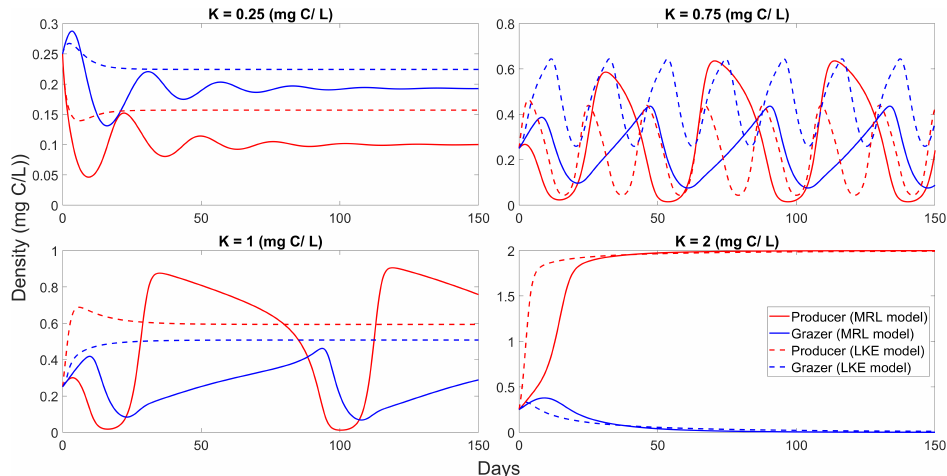
Figure 4. Comparison of model dynamics LKE (dashed curves) vs. the MRL model (solid curves). Red color indicates the producer, and blue indicates the